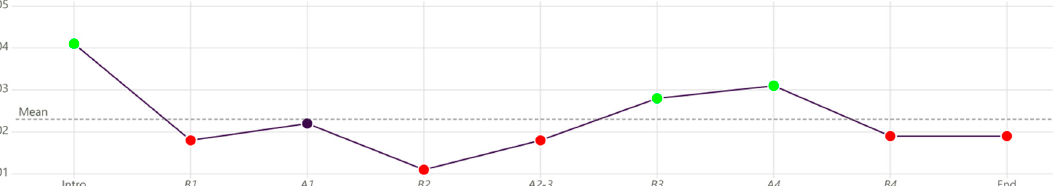
Figure 6. Beowulfian compounds per section.